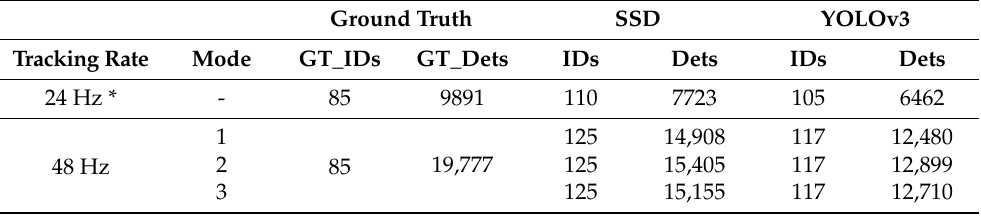
Table A1. The total number of IDs and detections for both the ground truth data and the predicted results for the different tracking configurations used in our evaluation. Our dataset has a total number of unique object ID trajectories of 85. The number of ground truth detections increases as the temporal resolution of the data